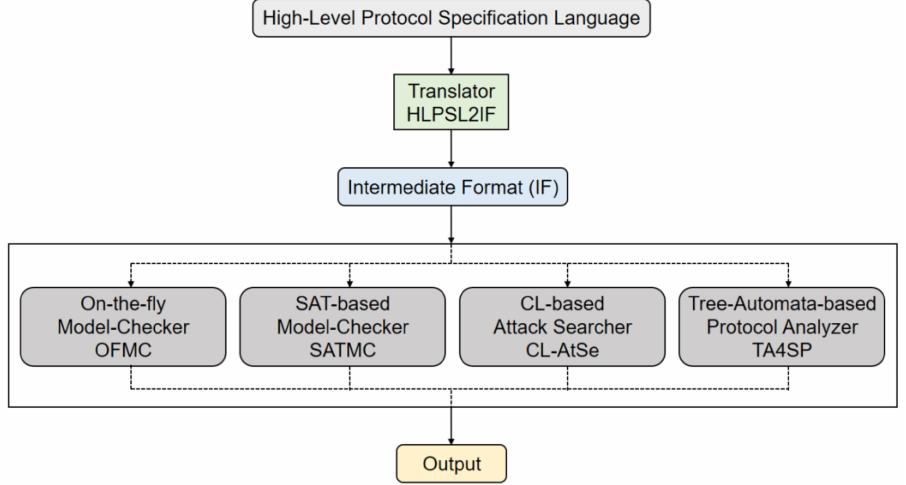
Figure 10. The typical AVISPA